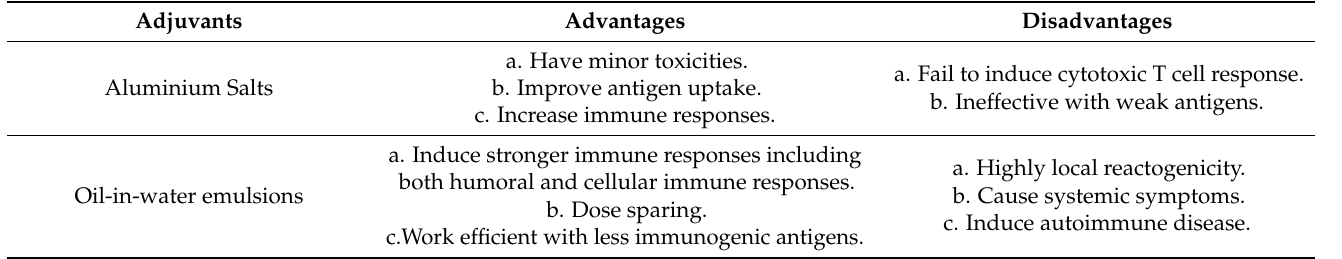
Table 1. Advantages and disadvantages of licensed influenza adjuvants.